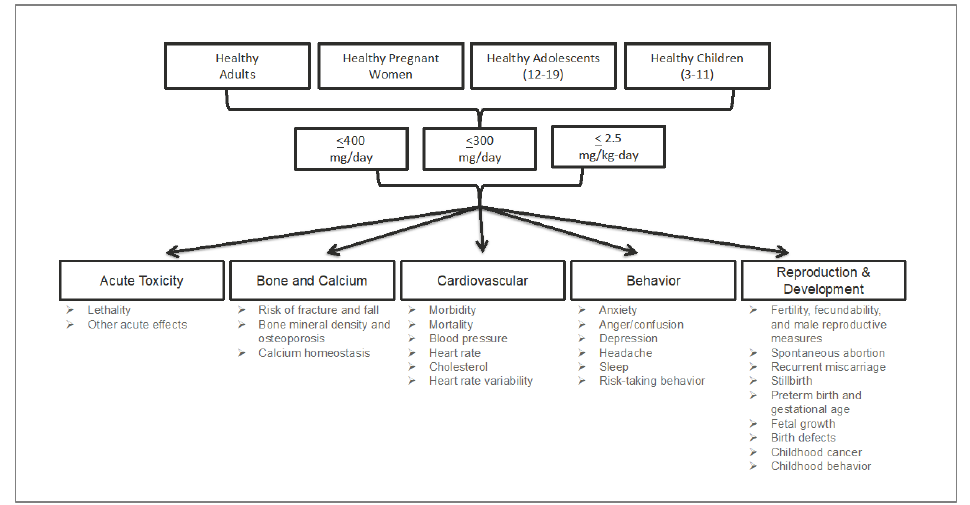
Figure 2. Populations, dose/intake levels, outcomes, and endpoints evaluated.